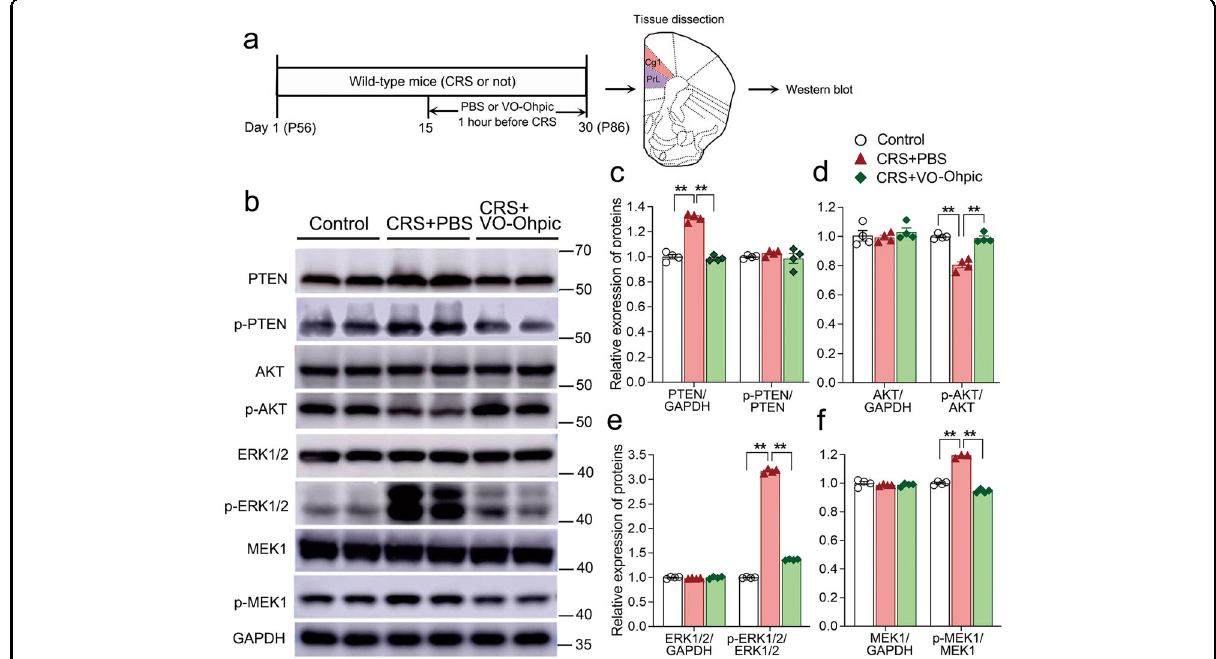
Fig. 2 The activity of PTEN signaling pathway is up-regulated in the PFC of CRS-treated mice, and it can be prevented by the administration of PTEN inhibitor. a Diagram of experiment design and timeline. Cortical tissues from the two subregions of PFC, Cg1, and PrL were collected for Western blots. b – f One-month CRS treatment led to the increase in the levels of PTEN, p-MEK1, and p-ERK1/2 and decrease of p-AKT in the PFC, but these changes were not observed in the CRS-treated mice receiving daily injection of PTEN inhibitor during the period of days 15 – 30. Note that the levels of p-PTEN, ERK1/2, AKT, and MEK1 were not changed by the CRS-treatment or application of PTEN inhibitor. n = 4 in each group and data are presented as mean ± SEM. Two-way ANOVA with post hoc Tukey ’ s test, * p < 0.05, ** p < 0.01. Cg1, cingulate cortex, area 1; CRS, chronic restraint stress; PrL, prelimbic cortex; VO-Ohpic, VO-Ohpic